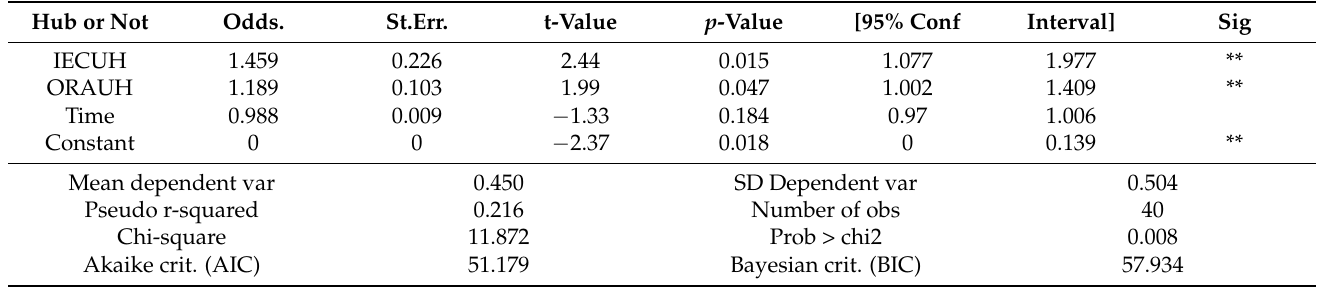
Table 4. Multiple variables logistic regression analysis.